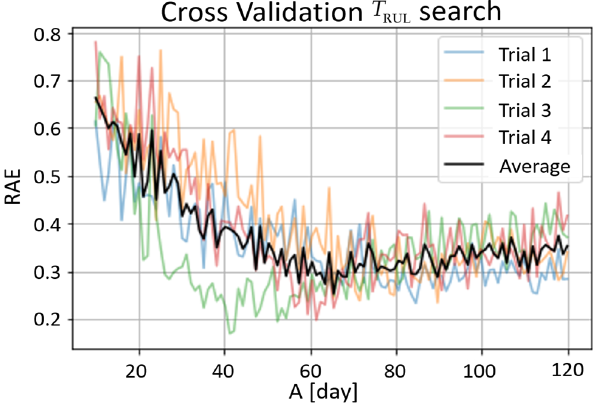
T search from 10 days to 120 days evaluated using RAE. Each data point Figure 9. Optimal Figure 9. Optimal T RUL search from 10 days to 120 days evaluated using RAE. Each data point RUL represents the RAE of an ERTs with 10 estimators trained on A/C combined dataset. represents the RAE of an ERTs with 10 estimators trained on A/C combined